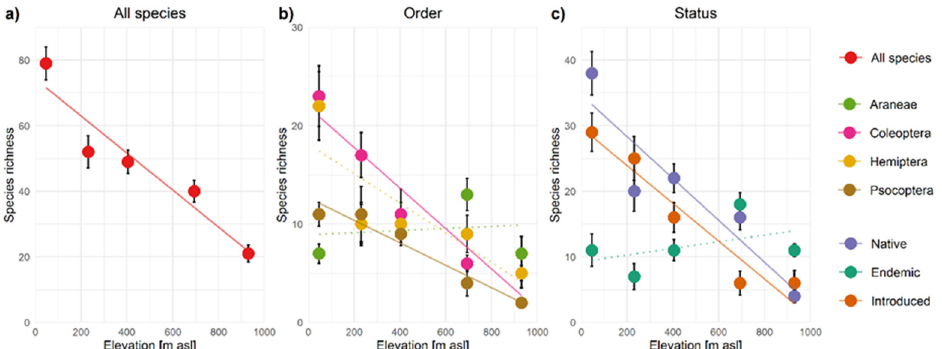
Figure 3. Observed species richness (S) patterns over the five sites on the elevation transect for: ( a ) all species, ( b ) four different orders and ( c ) native, endemic and introduced species. The error bars indicate standard deviations across four samples per elevation. The linear trendlines are shown as solid lines for species groups where p -values are <0.05 and indicated with dotted lines when p ≥ 0.05.